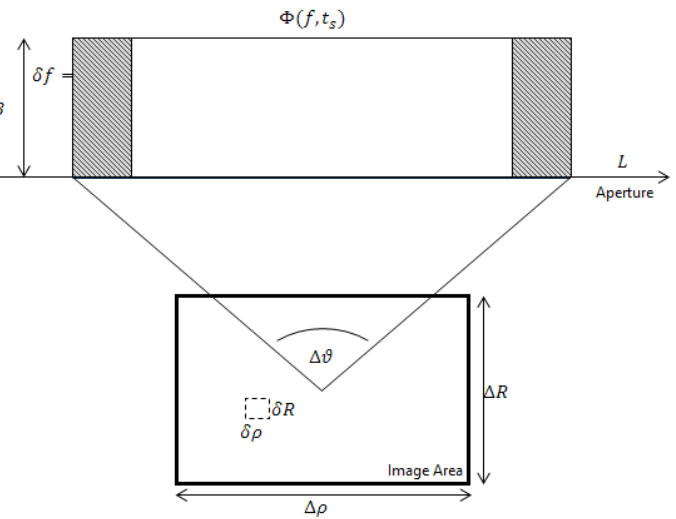
Figure 1. Comparing a full SAR aperture L of aperture angle ∆ θ with two smaller Nyquist-sampled apertures (grey areas) of bandwidth B , and attempting to reconstruct the full phase history Φ